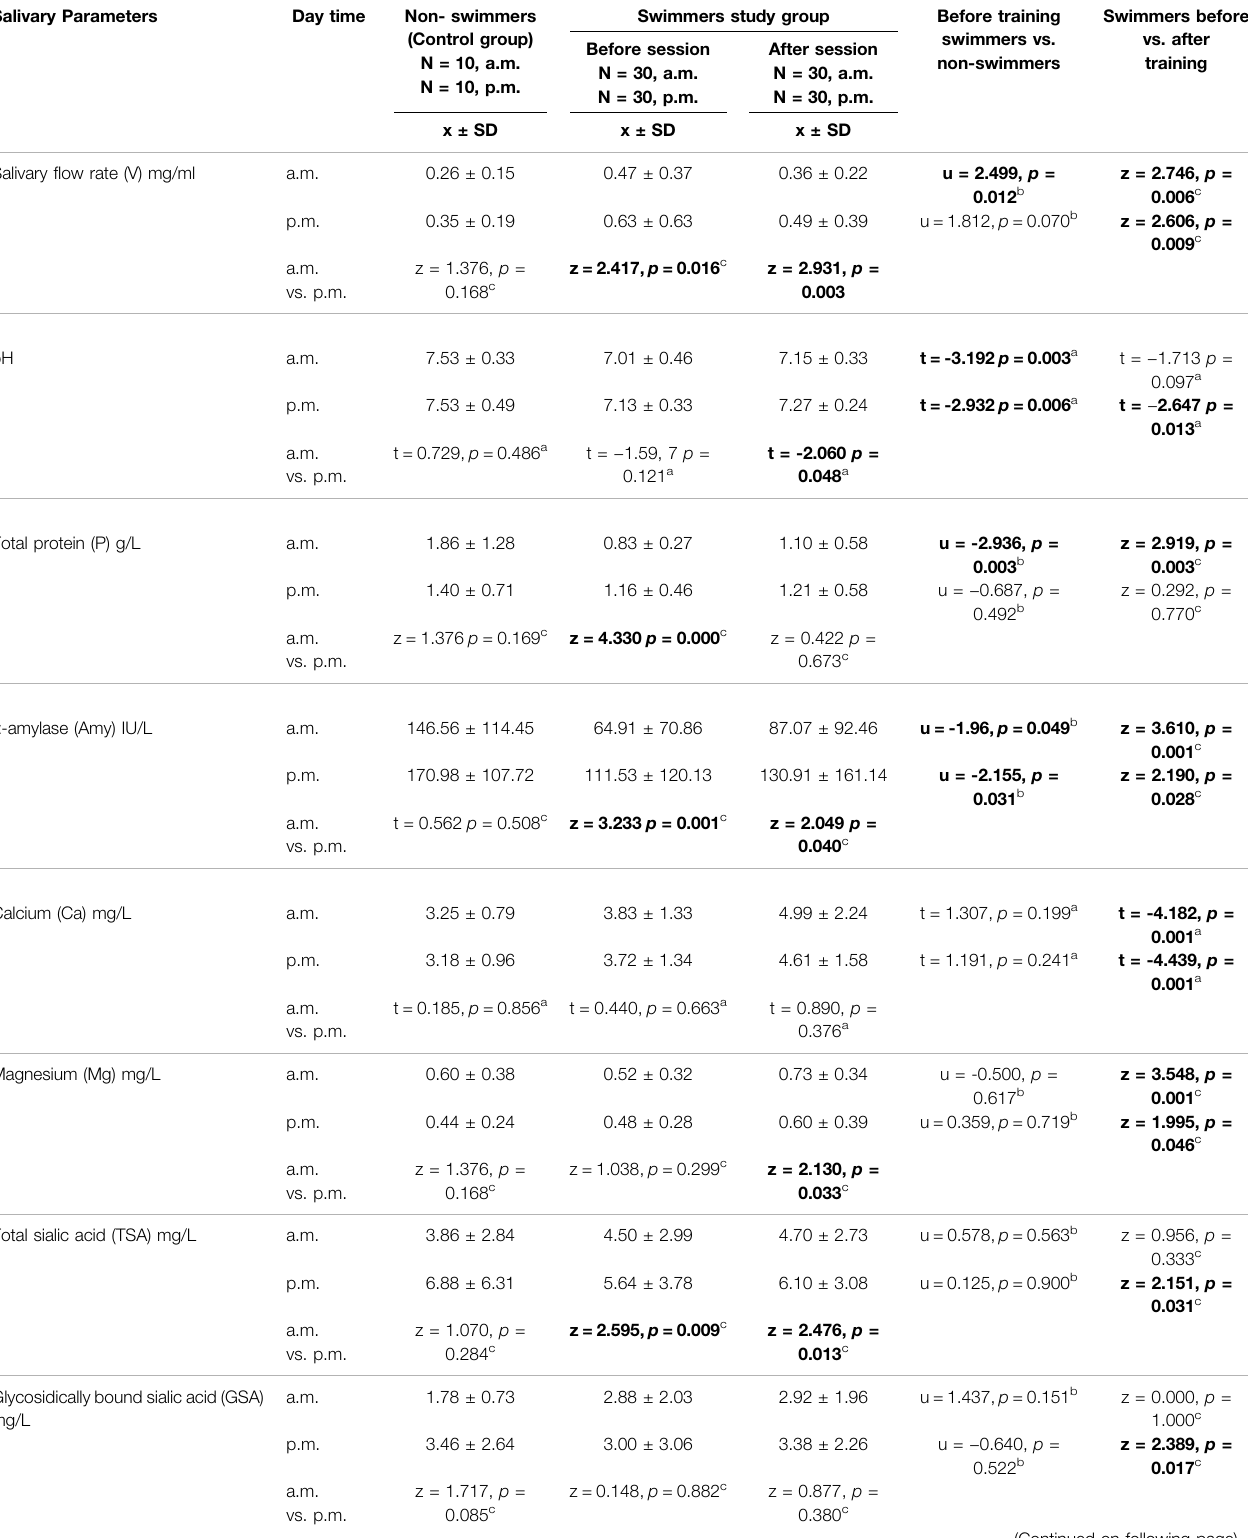
TABLE 1 | Concentration of the test components in saliva. Salivary